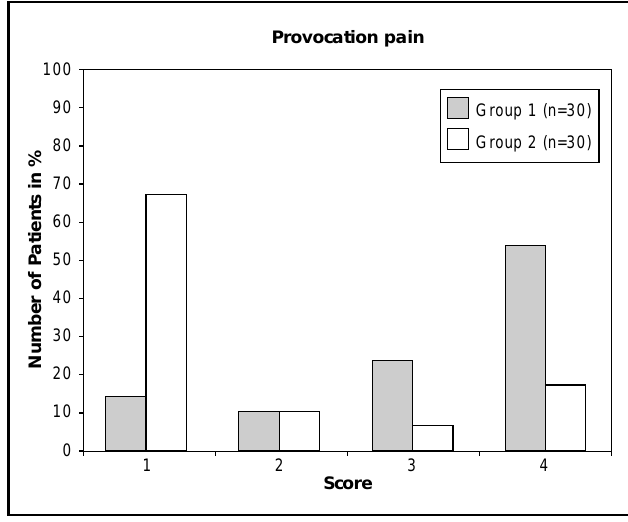
Figure 1: Number of patients with reduced grip strength at the end of six weeks of treatment in the comparison groups.